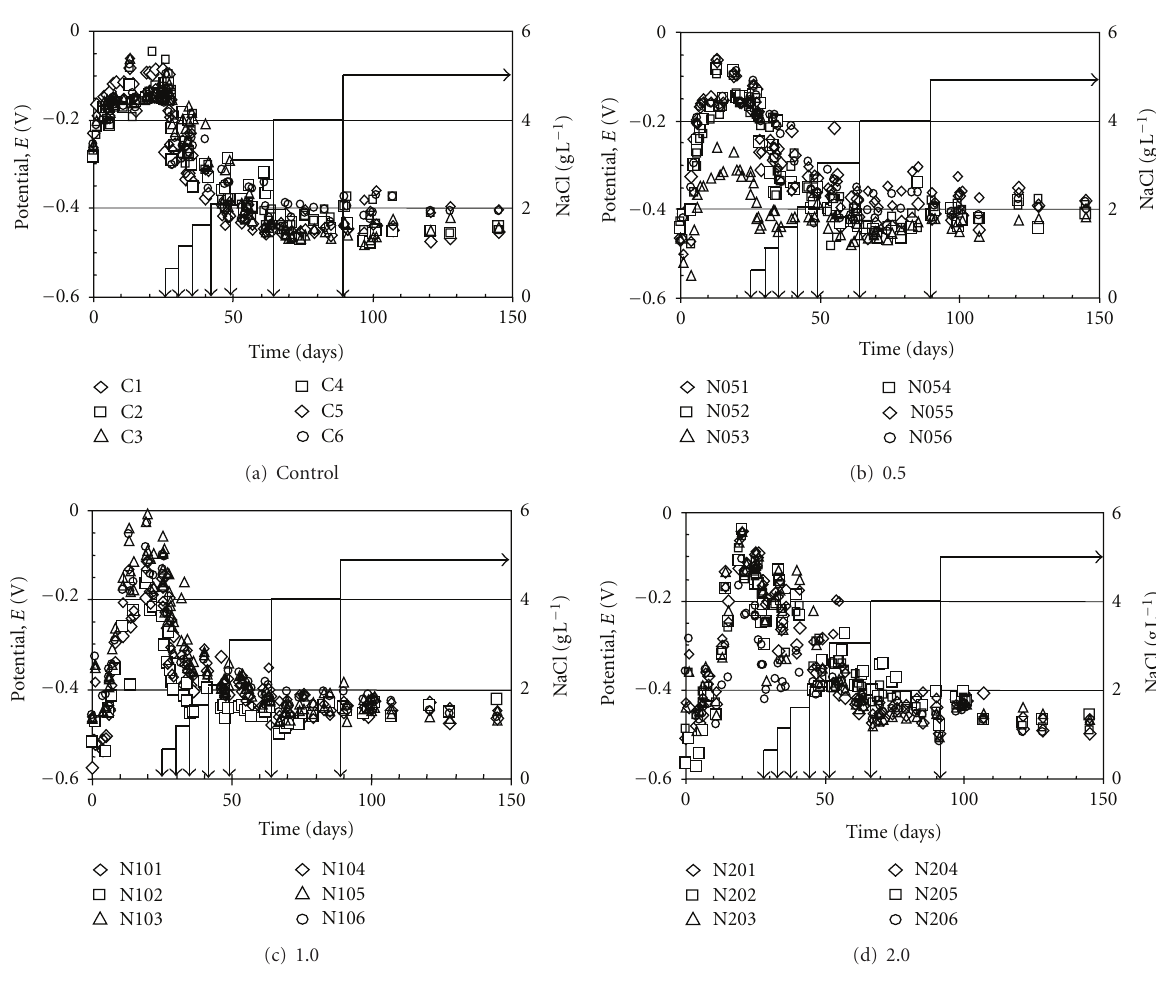
Figure 1: Half-cell potentials versus time of all SCH solution electrochemical cells